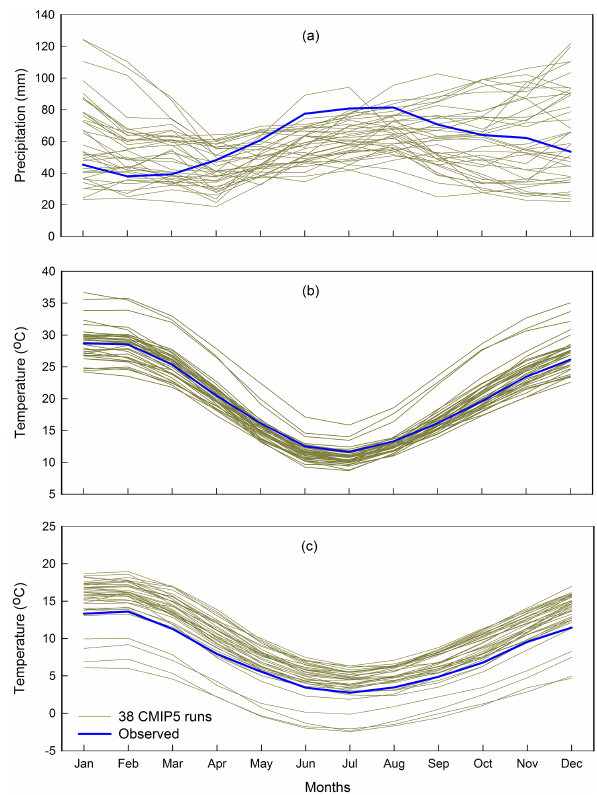
Figure 2. Long-term mean monthly climate observations plotted with the 38 CMIP5 runs during the baseline period (1980–2010) for the Goulburn–Broken catchment (a) long-term mean monthly precipitation, (b) long-term mean monthly maximum temperature, and (c) long-term mean monthly minimum